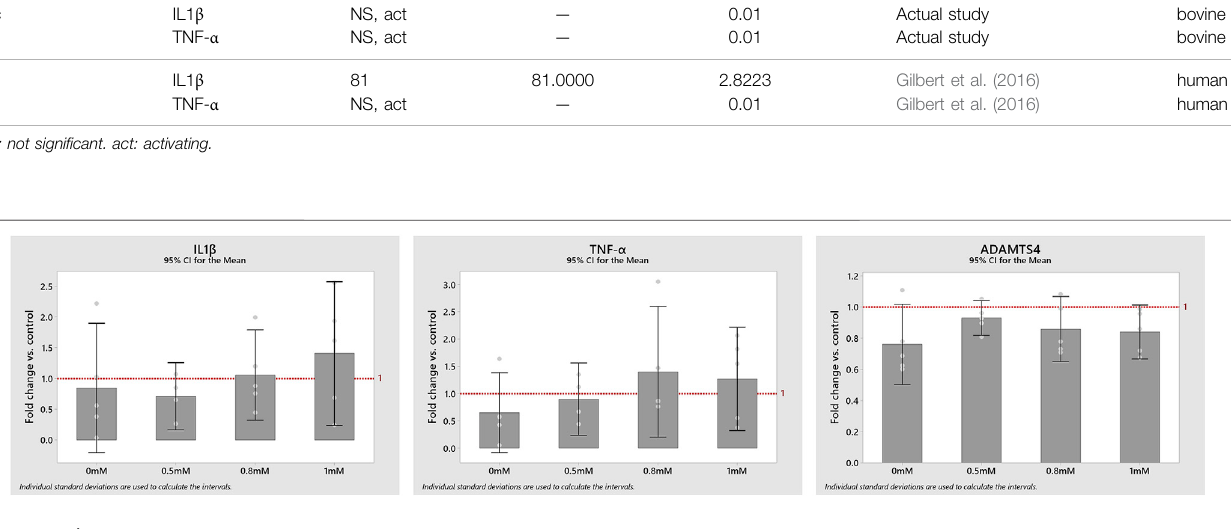
FIGURE 6 | mRNA expression of the proin fl ammatory cytokines IL1 β and TNF- α and the protease ADAMTS4 at 0, 0.5, 0.8 and 1 mM glucose concentrations compared to control (1-fold). Data is displayed as mean values with a corresponding 95% con fi dence interval and individual values (round dots).